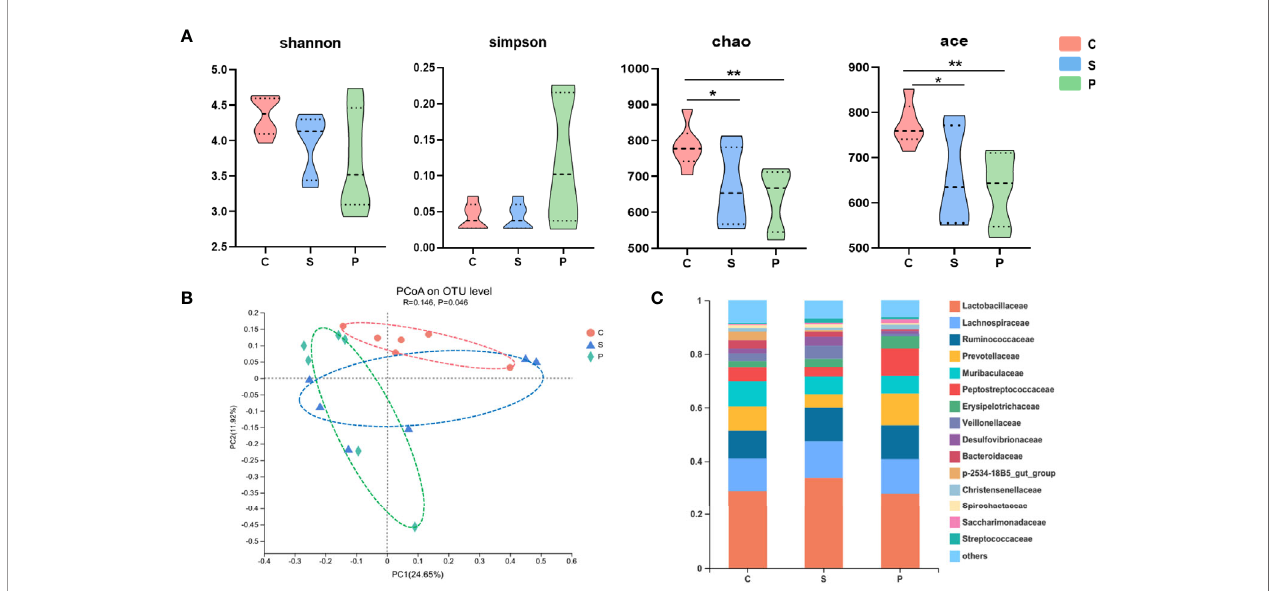
FIGURE 3 | Gut microbial characteristics of control, stroke and PSD. (A) a -phylogenetic diversity analysis showing that PSD subjects were characterized by lower microbial richness in two indexes (Ace, Chao) relative to controls (n=6 per group), *P < 0.05, **P < 0.01. (B) At the OTU level, principal co-ordinates analysis (PCoA) showed gut microbial composition of rats with PSD was signi fi cantly different from that in control and stroke (n = 6 per group). (C) Relative abundance of gut microbes at the family level.